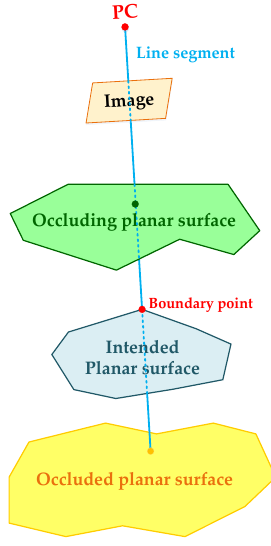
Figure 10. The surfaces occluding (green surface) and being occluded (yellow surface) by a boundary point of the intended planar surface.